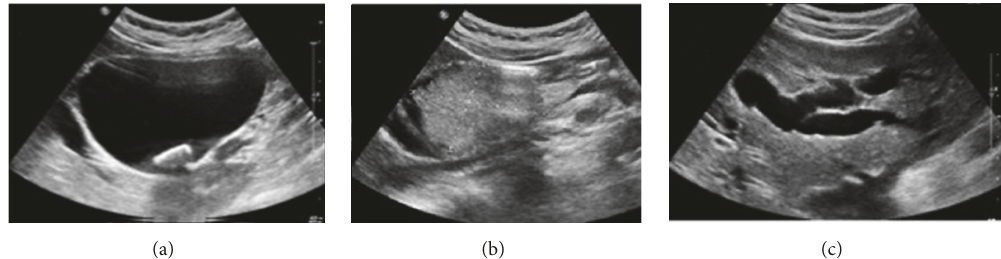
Figure 1: Ultrasound transverse sections. (a) Cystic mass with a gallstone independent of the gallbladder. (b) Intracystic tissue bud. (c) Dilatation of the intrahepatic bile ducts.